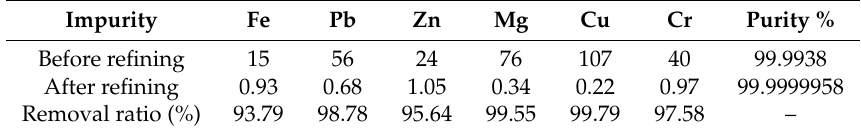
Table 1. Impurity concentration ( × 10 − 6 , wt.%) and purity of Ga during and after refining.